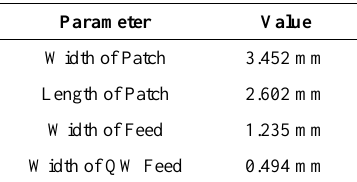
Table 2. List of Parameters